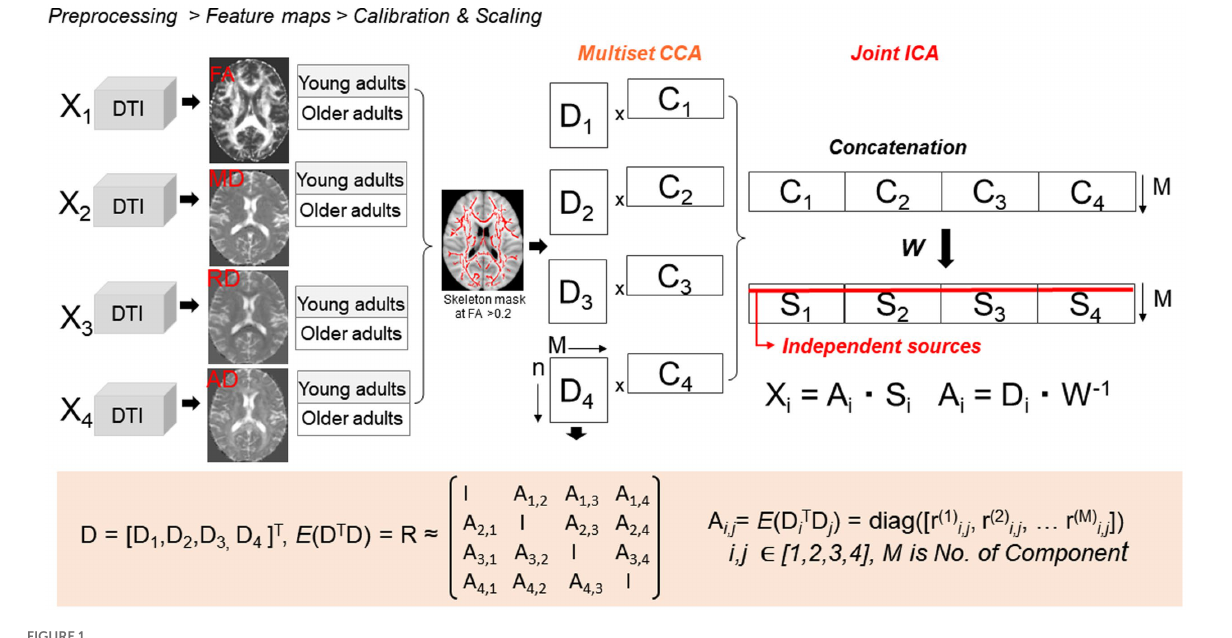
FIGURE 1 Four-way two-sample t -test mCCA + jICA. mCCA projects the data in a space so that the correlations among mixing profiles (D k , k = 1… n ) of the four parameter maps are jointly maximized, resulting in canonical variates. Analyses were restricted to the WM using a TBSS-derived skeleton WM mask. D k is then sorted by correlation to provide a closer initial match and make the further application of joint ICA more reliable. Joint ICA is then applied on the concatenated maps (C n ) to obtain the final independent sources S k